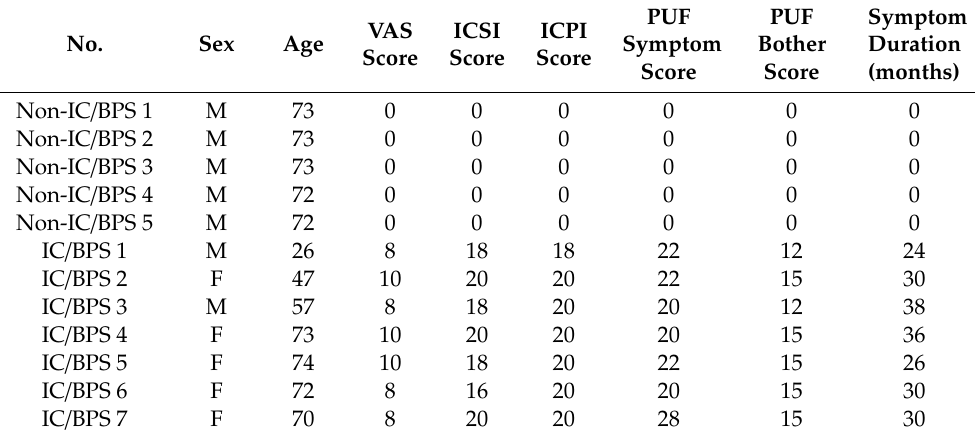
Table 3. Clinicopathological characteristics of the study